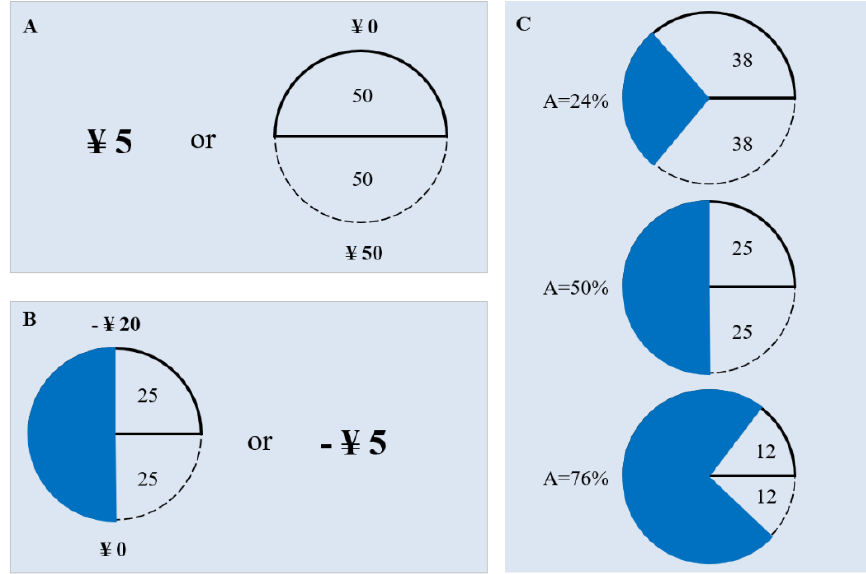
Figure 1. Experimental design. ( A ) Example of risky gain trial. The participant chose between RMB 5 and a lottery of winning RMB 50 or nothing with an equal probability. ( B ) Example of ambiguous loss trial. The participant has a choice between losing RMB 5 and a lottery of losing RMB 20 with unknown probability. ( C ) Ambiguity levels used in the experiment.